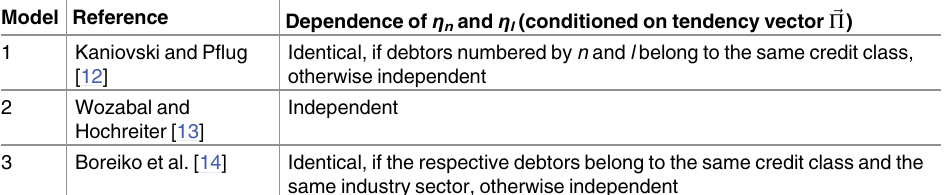
Table 2. Three coupling